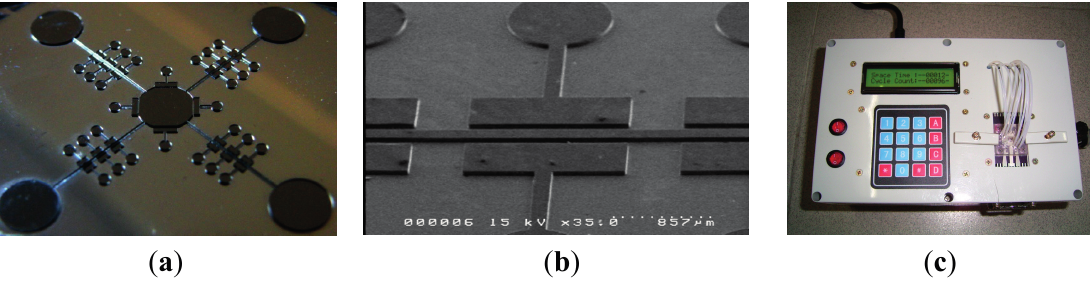
Figure 3. ( a ) Photograph of the SU-8 template for the micropump chip; ( b ) SEM image showing a close-up view of the SU-8 template; ( c ) photograph of the hand-held digital